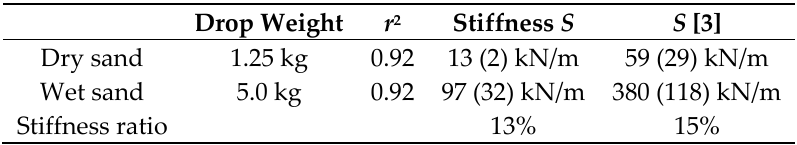
Figure 2. The indentation depth plotted as a function of the weight release height h as discrete points for the two sand surfaces. The two continuous straight lines show a linear relationship (Pearson correlation coefficient r 2 > 0.92). Table 1. Comparison of stiffness values for dry and wet sand. The standard deviation from the measurements is given in brackets. The results from a previous study [3] are given for comparison. The stiffness ratio between dry and wet sand is given as a percentage